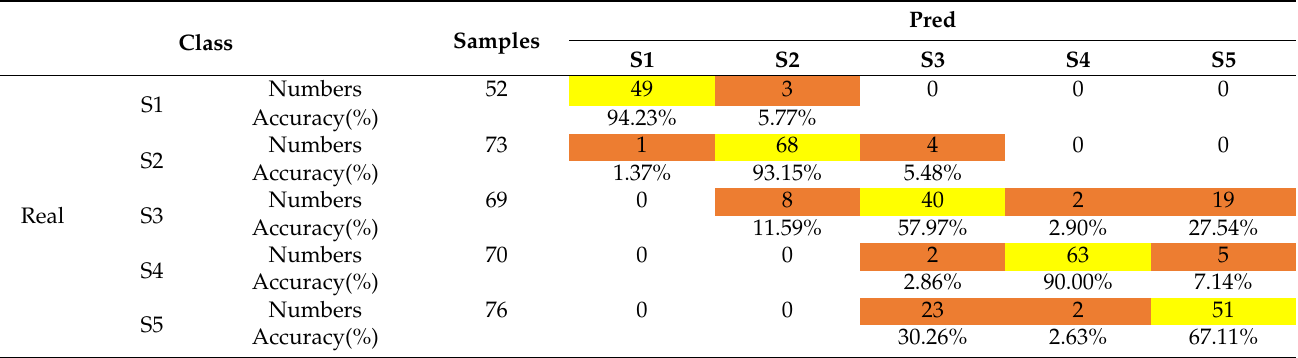
Table 3. The performance of Group